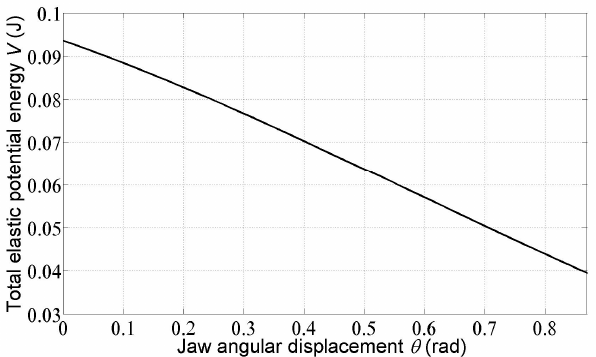
Figure 7. Dependence of the total elastic potential energy of the driving and compensation springs on the jaw angular displacement θ .